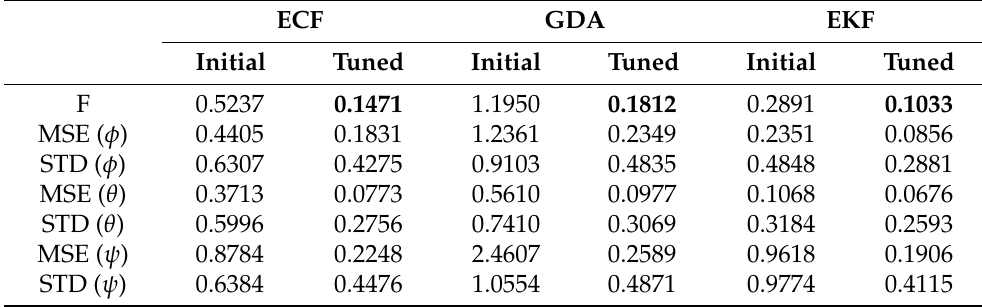
Figure 10. Initial and tuned performance of the standard extended Kalman filter (EKF). Table 3. Outcome of filter analysis. The bold values indicate the tuned filter